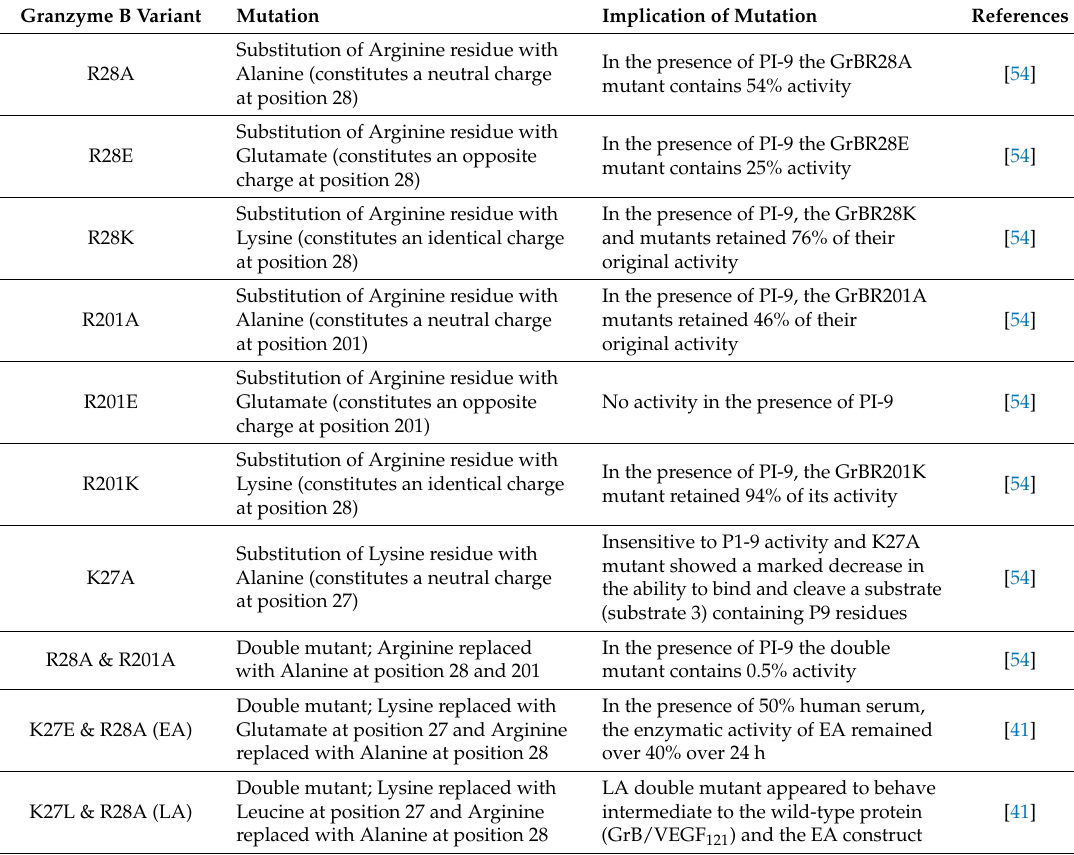
Table 3. Granzyme B variants to improve cytotoxicity and bypass serpin B9